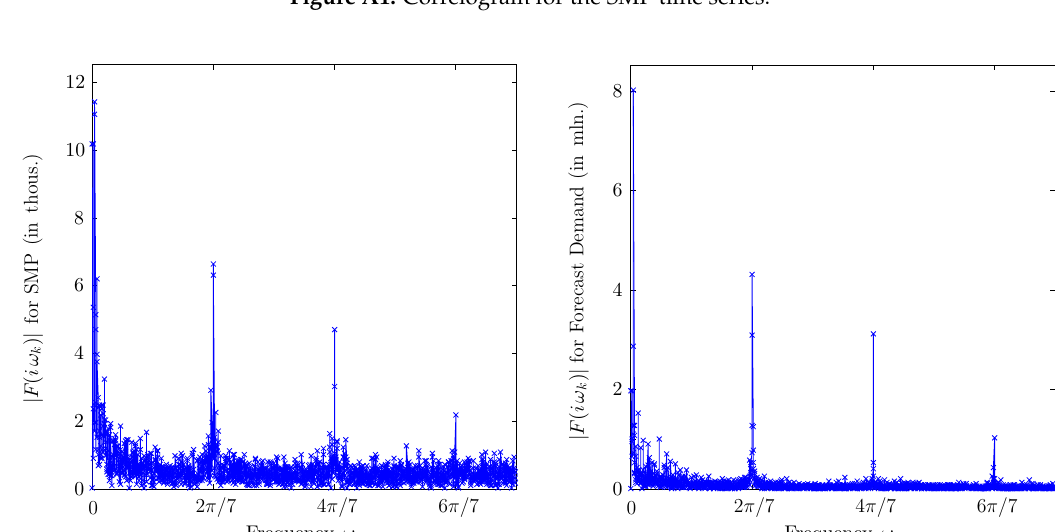
Figure A1. Correlogram for the SMP time series.